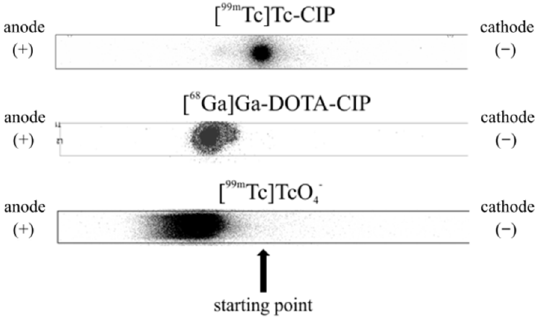
Figure 6. Electrophoresis analyses of [ 99m Tc]Tc-CIP, [ 68 Ga]Ga-DOTA-CIP and [ 99m Tc]TcO 4 − radiocompounds in 0.01 M phosphate buffer pH 7.40.